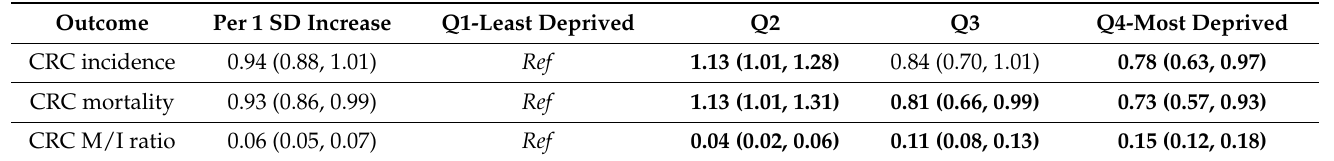
Table 1. Relative risk (and 95% Credible Intervals) of CRC incidence and mortality and levels of CRC Mortality-To-Incidence ratio (M/I ratio) per one standard deviation (SD) increase across quartiles of socioeconomic deprivation index ( n = 369 geographical